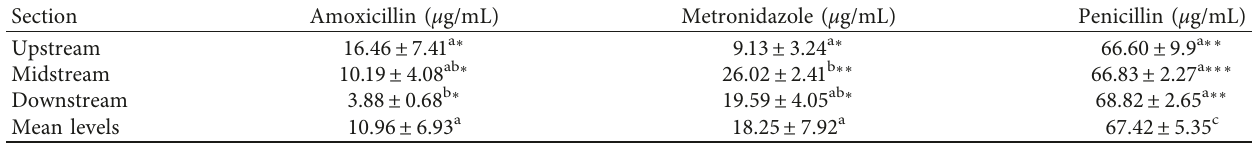
Table 3: Levels of antibiotics in leachates at different sections of the flow from